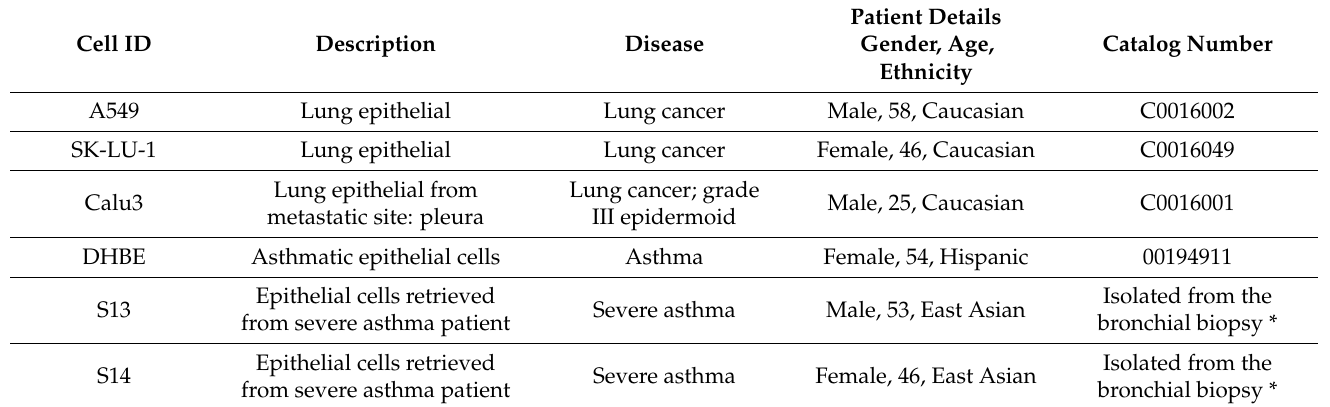
Table 4. List of cell lines used in the study for molecular